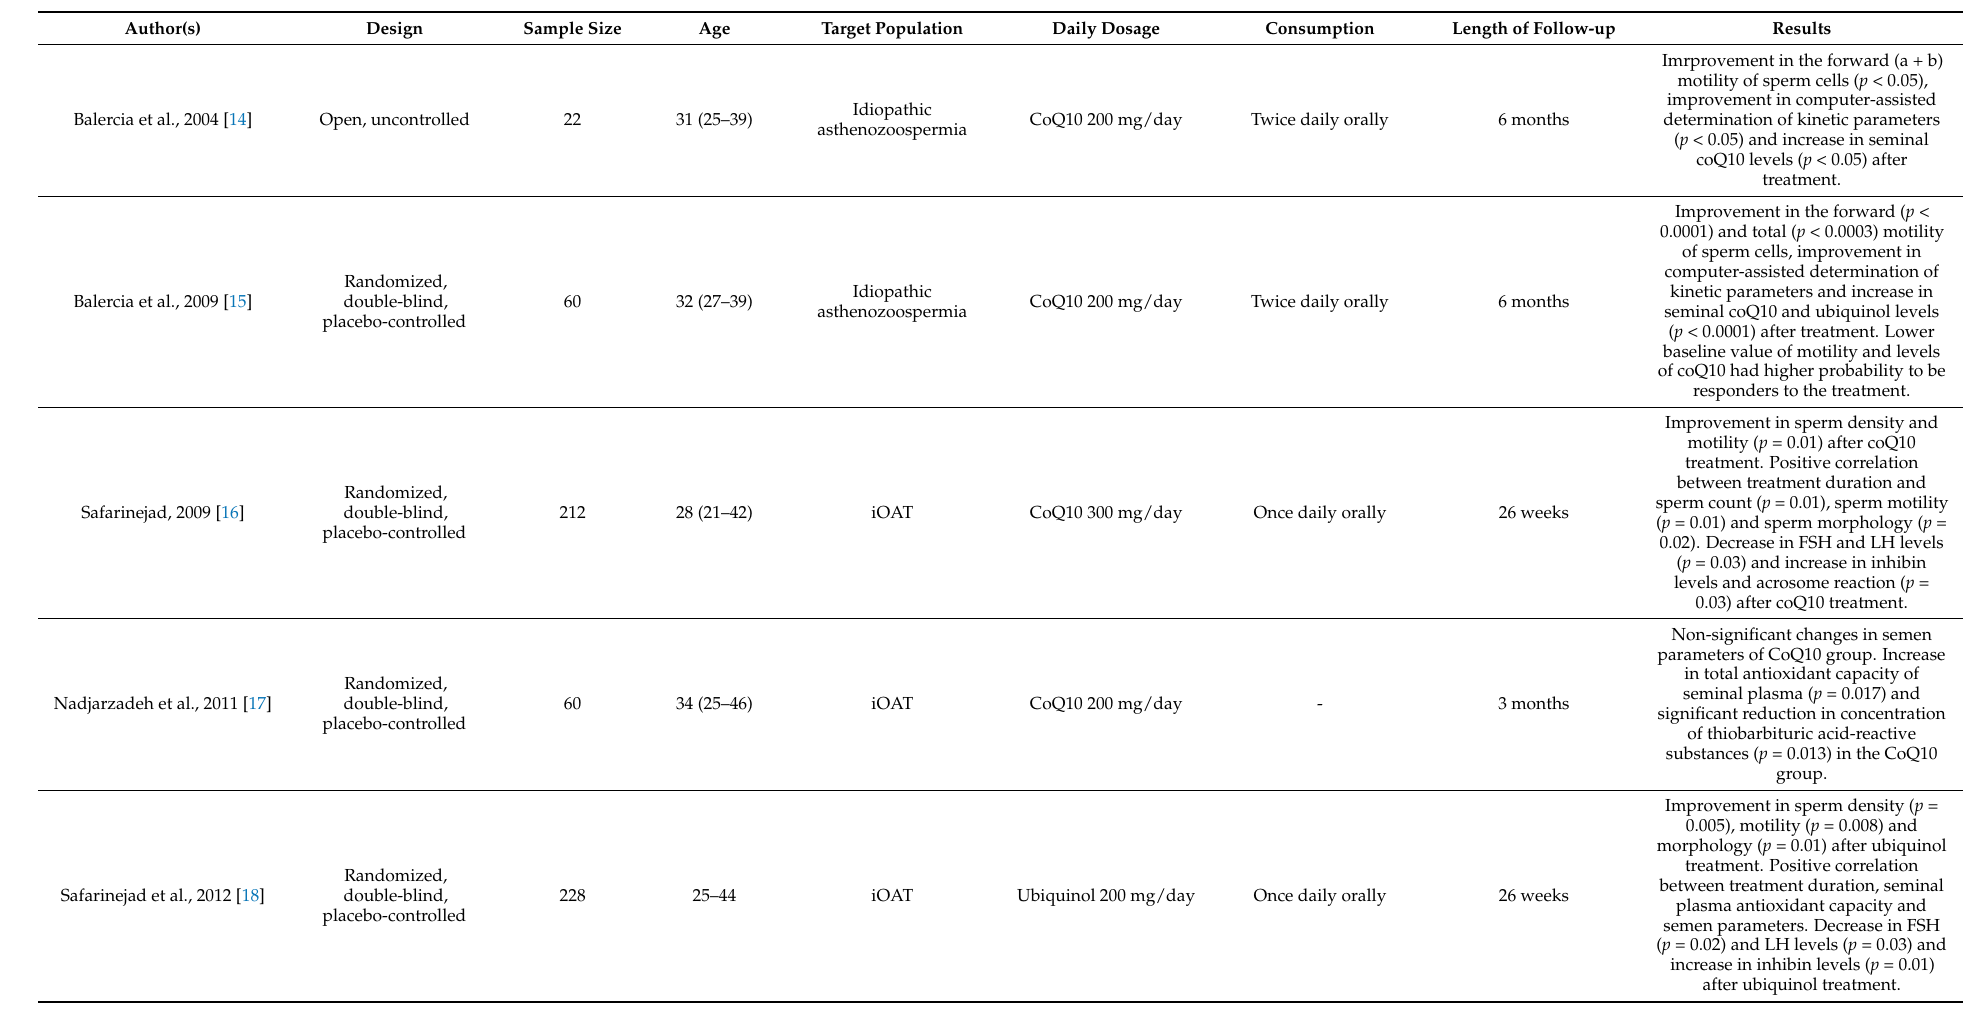
Table 1. Coenzyme Q10 and male fertility (monotherapy), characteristics of suitable